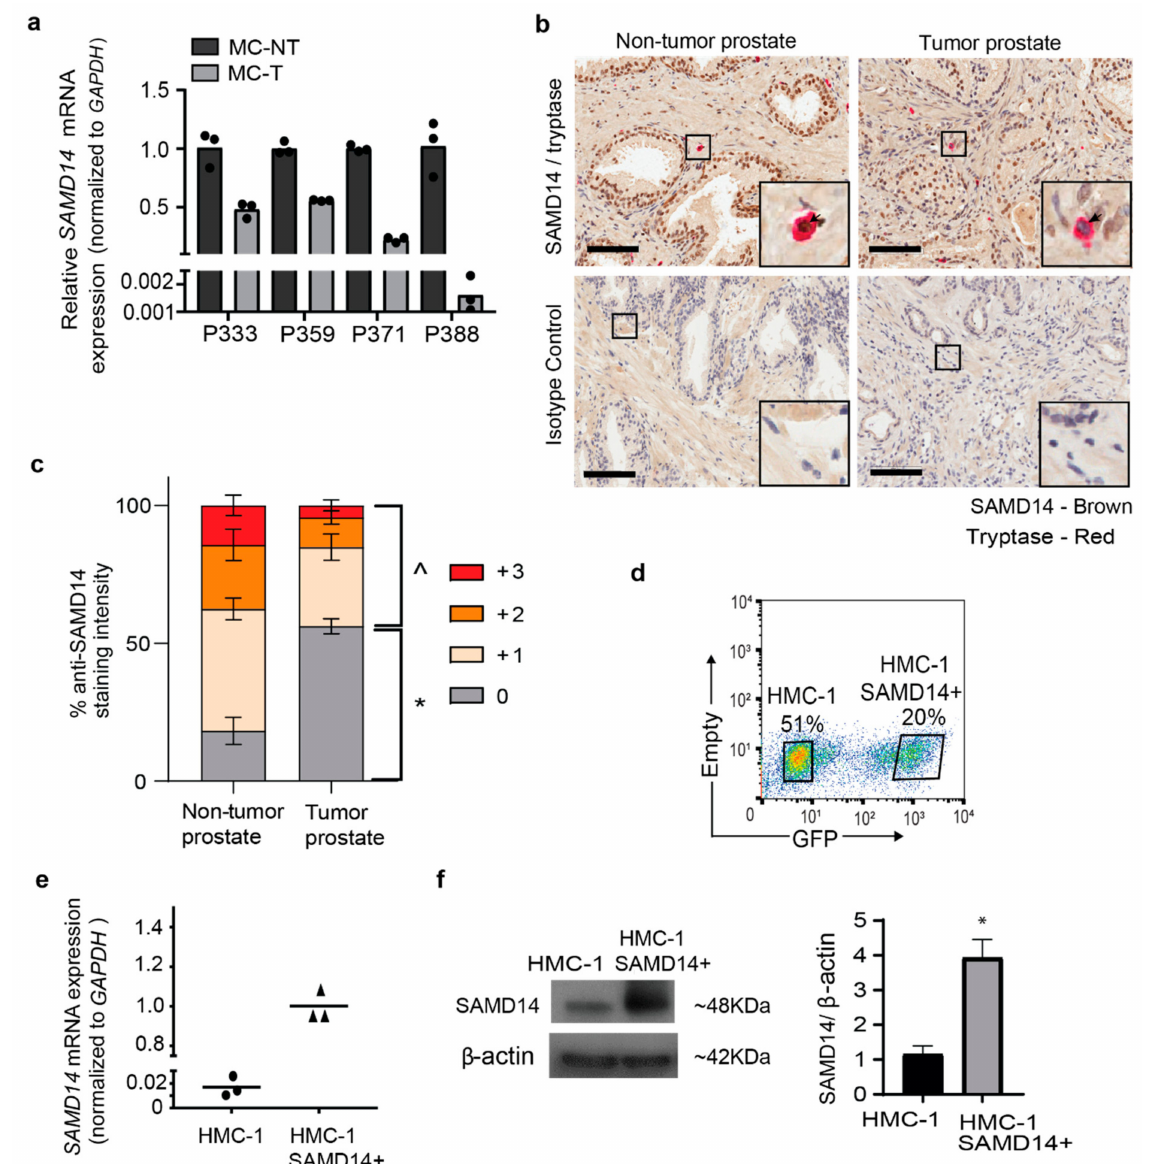
Figure 2. SAMD14 expression in primary mast cells. ( a ) SAMD14 mRNA expression in validation cohort of mast cells isolated from tumor (MC-T) and non-tumor (MC-NT) regions of human prostate tissue (n = 4 patients) normalized to GAPDH. ( b ) Images show representative human prostate tissue sections stained with SAMD14+ (brown) and tryptase+ mast cells (red) and corresponding isotype controls in matched non-tumor and tumor prostate tissues. Scale bars = 100 µ m. Images are representative; n = 3 patients. ( c ) Semi-quantitative scoring of SAMD14 staining intensity in tryptase+ mast cells in non-tumor and tumor prostate tissue sections. Bar graph shows the average percentage ( ± SEM) SAMD14 staining intensity of 3 individual patient tissues (two-way ANOVA Sidak’s multiple comparisons test between tumor and non-tumor prostate tissue regions; ˆ p < 0.0001 total SAMD14 positivity; * p < 0.0001 total SAMD14 negativity). ( d ) Flow cytometric plot shows isolation of live HMC-1-SAMD14 + cell-based GFP expression. Viable cells are gated using propidium iodide. Plot is representative; n = 5. ( e ) SAMD14 mRNA expression in FACS-purified GFP- (HMC-1) and GFP+ (HMC-1-SAMD14+) viable cells normalized to GAPDH . ( f ) Western blot show SAMD14 protein expression and β -actin loading control in HMC-1 and HMC-1-SAMD14+ purified cell populations; 25 µ g of protein was loaded per lane. Quantification of blot by densitometry shows the average fold-change of SAMD14 expression in HMC-1 and HMC-1-SAMD14+ cells (unpaired student t -test; p < 0.005). Replicate and uncropped SAMD14 and β -actin western blots are shown in Figure